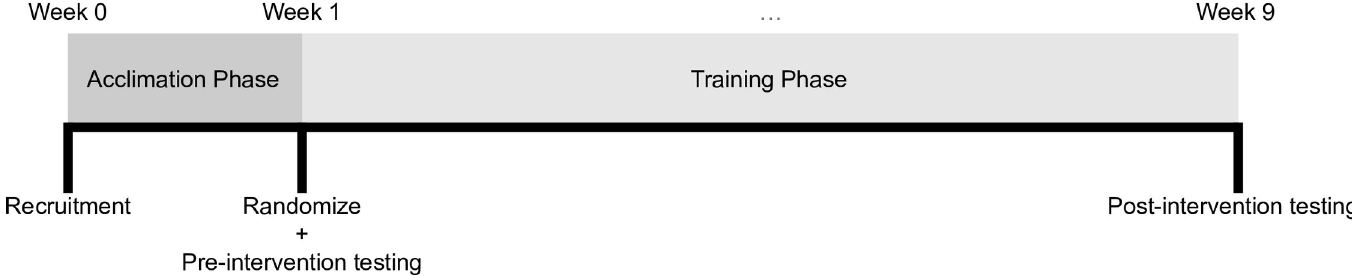
Fig 1. Study timeline. After being accepted into the study, all participants went through a 1-week acclimation phase. Thereafter, the limbs of participants were randomized to their respective conditions and underwent preintervention testing. The intervention lasted 8 weeks, after which participants underwent postintervention